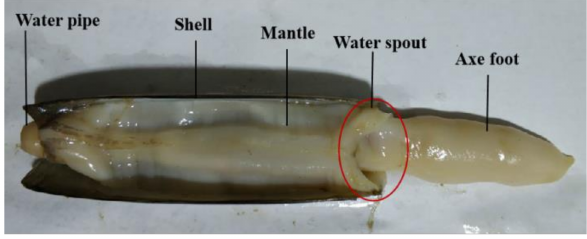
Figure 7. Anatomical image of the Solen strictus